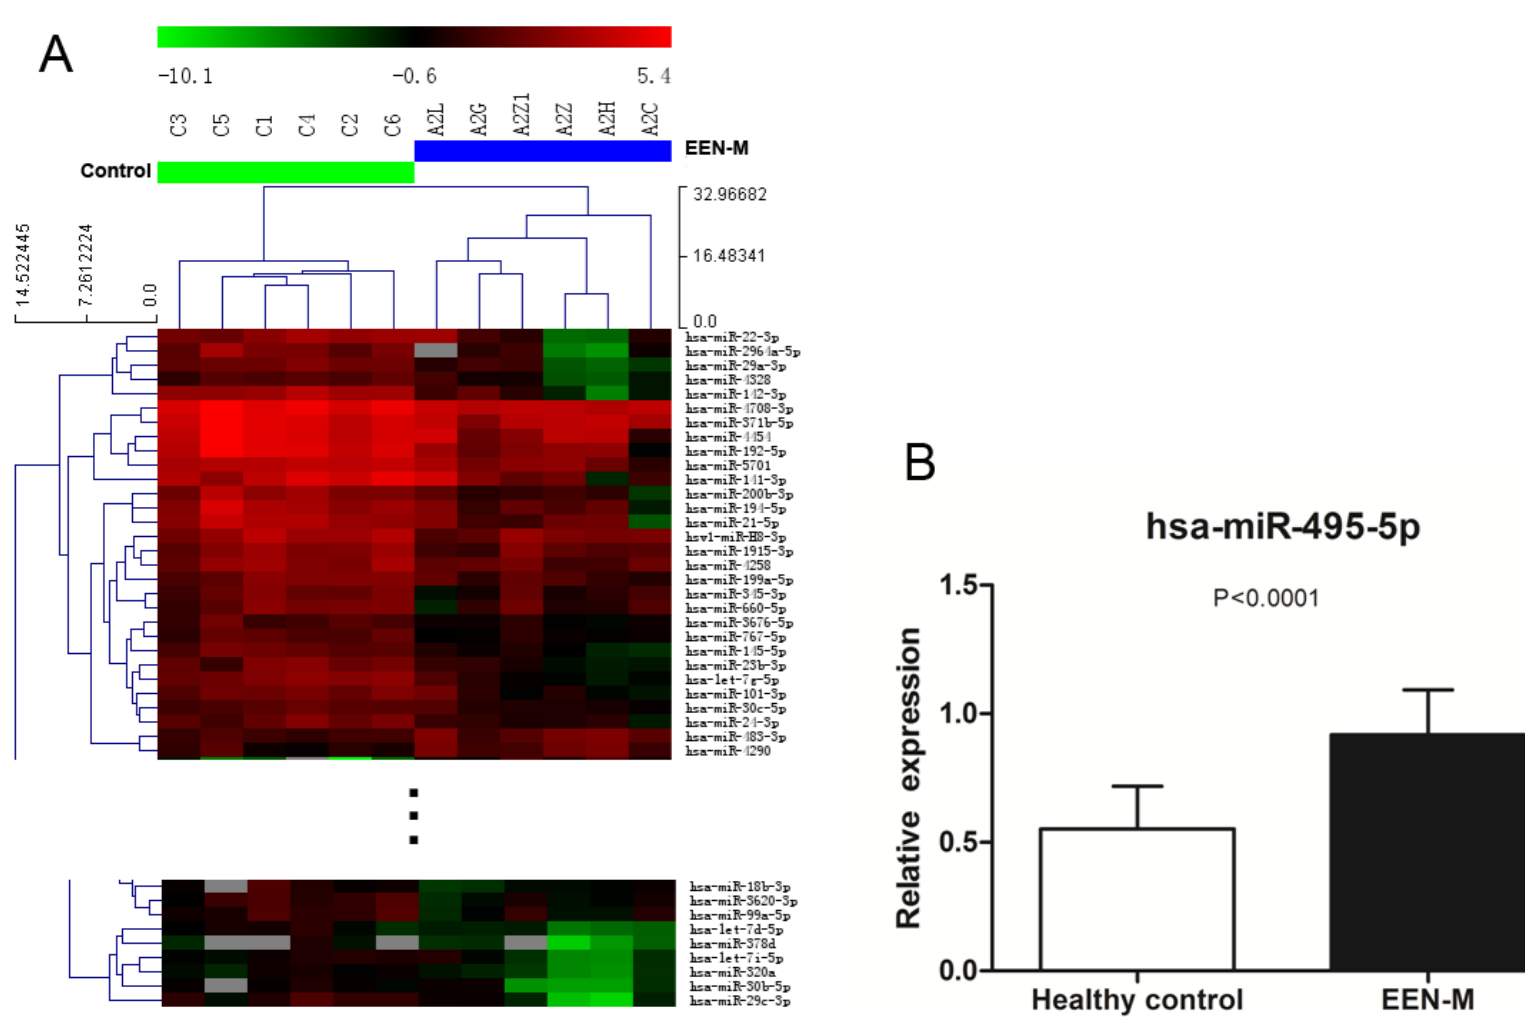
Figure 3. Comparison between EEN ‐ M and healthy control: ( A ) heat map of differentially expressed miRNAs clearly separated EEN ‐ M and normal samples; and ( B ) qRT ‐ PCR validation of miRNAs differentially expressed in EEN ‐ M.